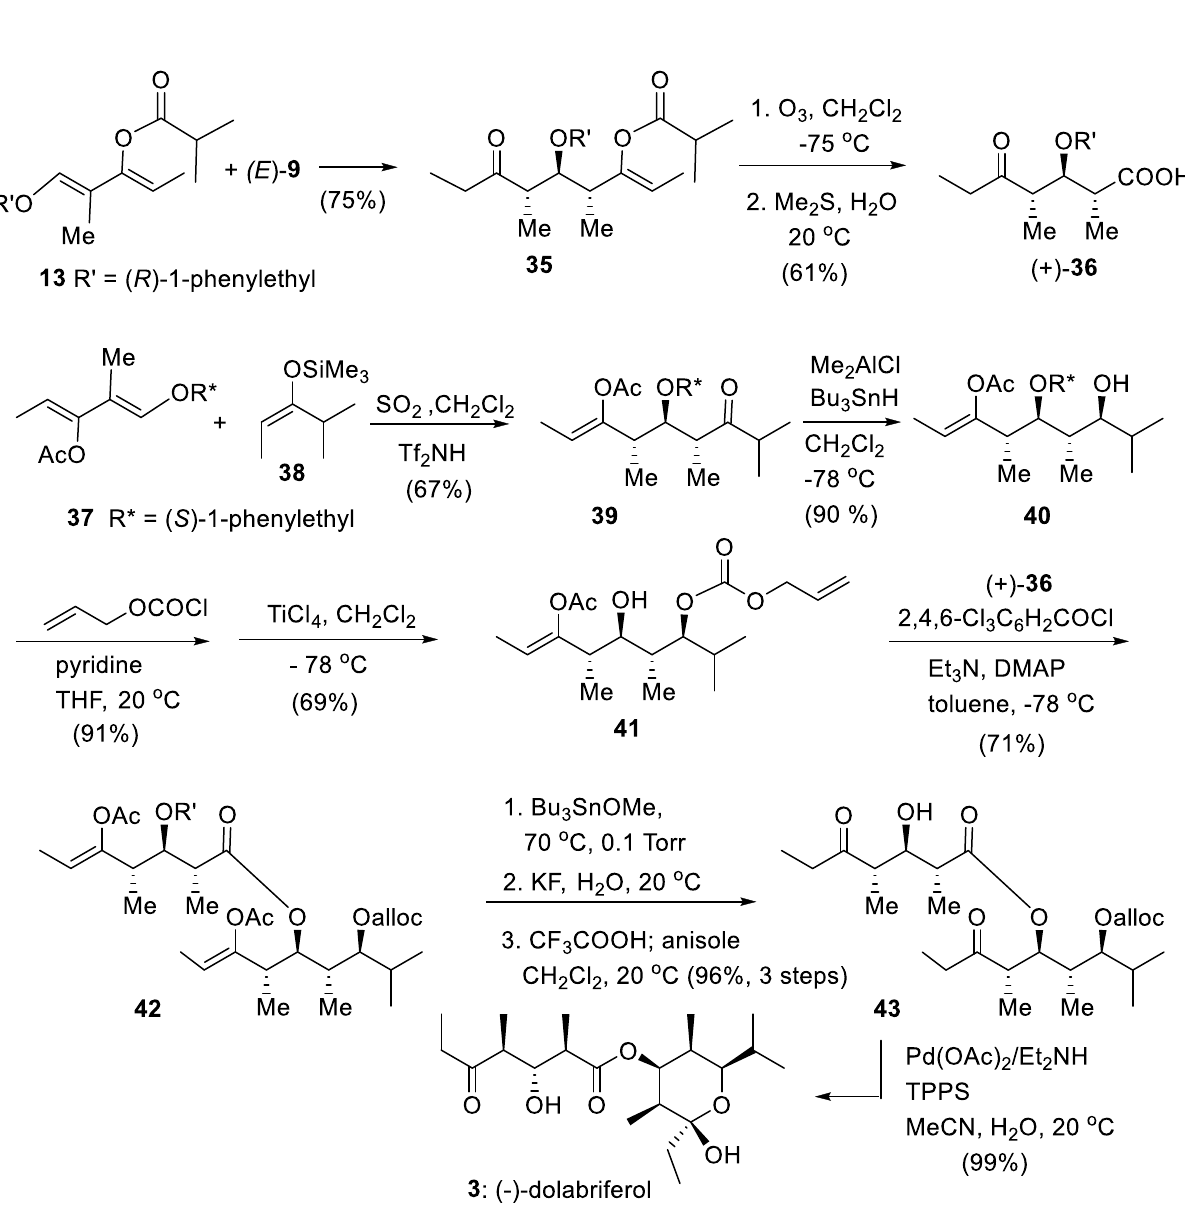
Scheme 7. Total asymmetric synthesis of